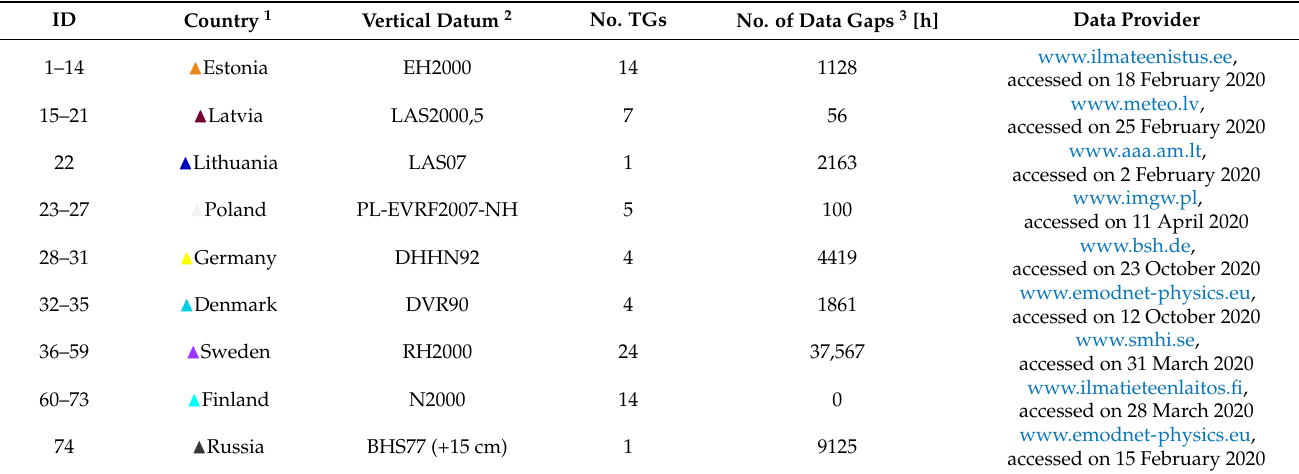
Table 1. Used TG stations of each country, their vertical datums, and the data agency.